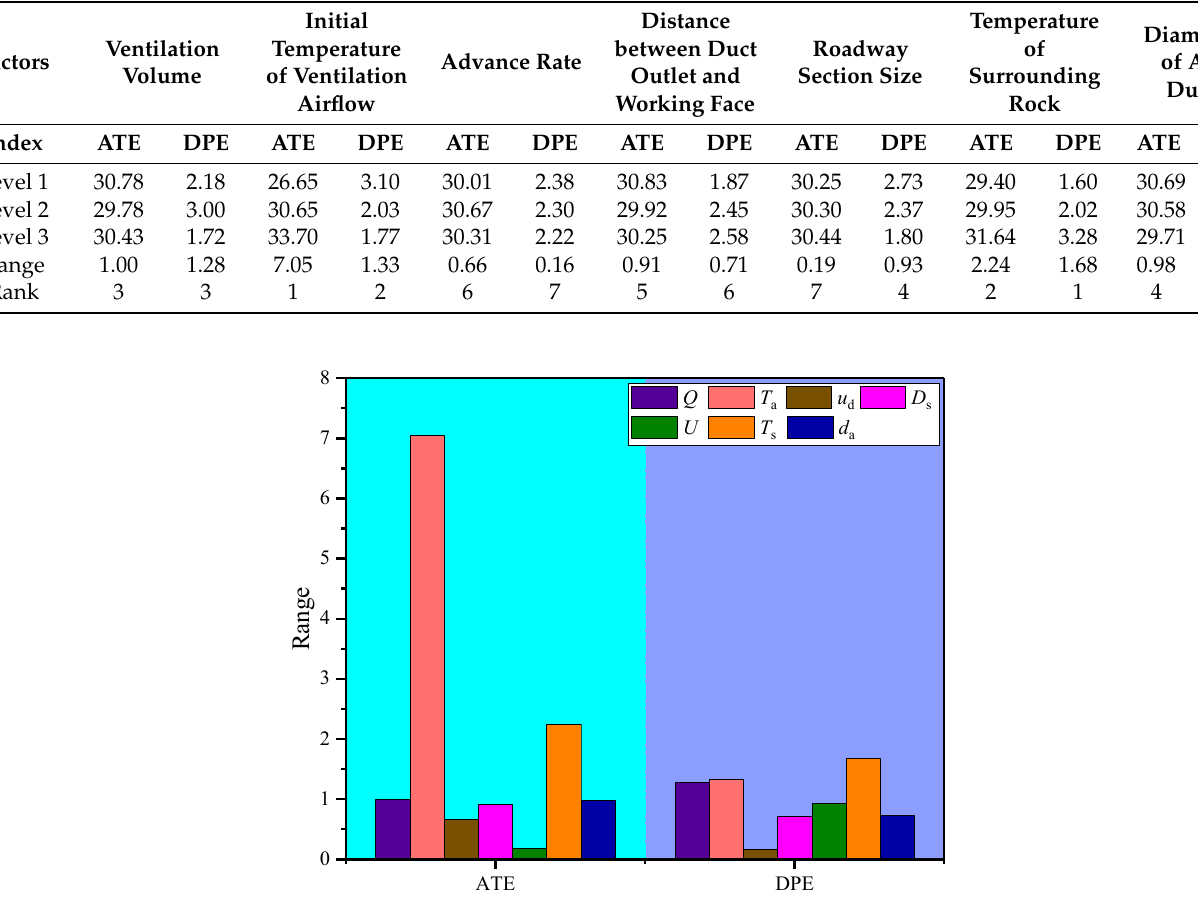
Figure 19. Sensitive comparison of the factors on the indexes of ATE and DPE.